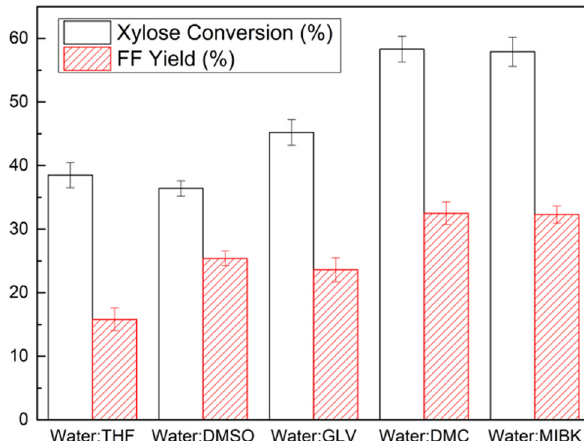
Figure 8: E ff ect of solvent on the conversion from xylose to FF. xylose.